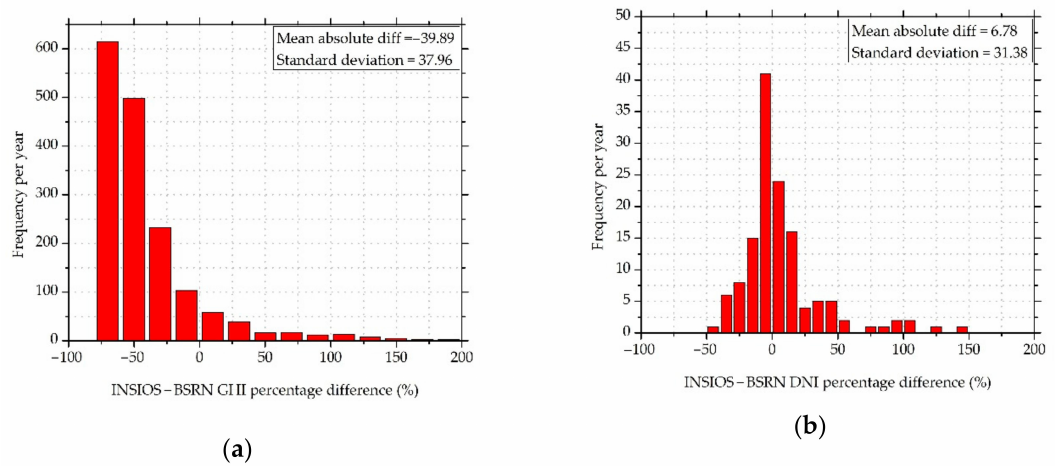
Figure 10. Frequency histogram of the percentage di ff erence between INSIOS estimations and BSRN measurements for ( a ) GHI and ( b ) DNI for all stations.